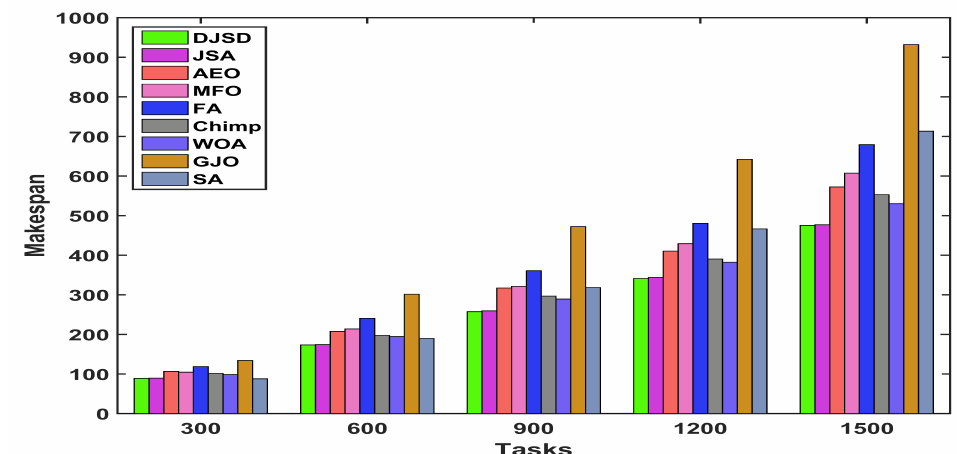
Figure 7. Average makespan for the synthetic workload.